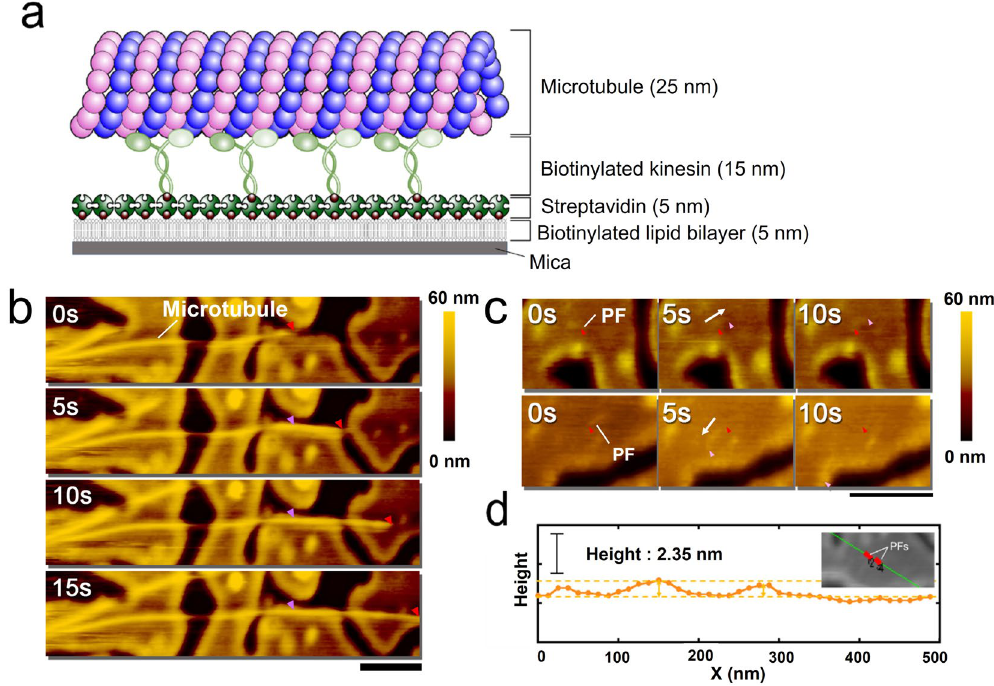
Figure 1. HS-AFM observation of gliding MTs. ( a ) Schematic illustration of in vitro gliding assay of MTs on kinesins fixed to a mica supported lipid bilayer through streptavidin/biotin interaction. ( b ) Time lapse images showing gliding motion of a MT on the kinesin coated lipid surface. Scale bar: 500 nm, frame rate: 0.2 s/frame. ( c ) Observation of a gliding PF by using HS-AFM. Scale bar: 500 nm, frame rate: 0.2 s/frame. In ( b ) and ( c ), the pink/red arrows indicate change of position of gliding MT or short PF with time and white arrows show their moving direction. ( d ) Height profile of gliding PFs obtained from HS-AFM image as shown in the inset. Red points in the insets show two